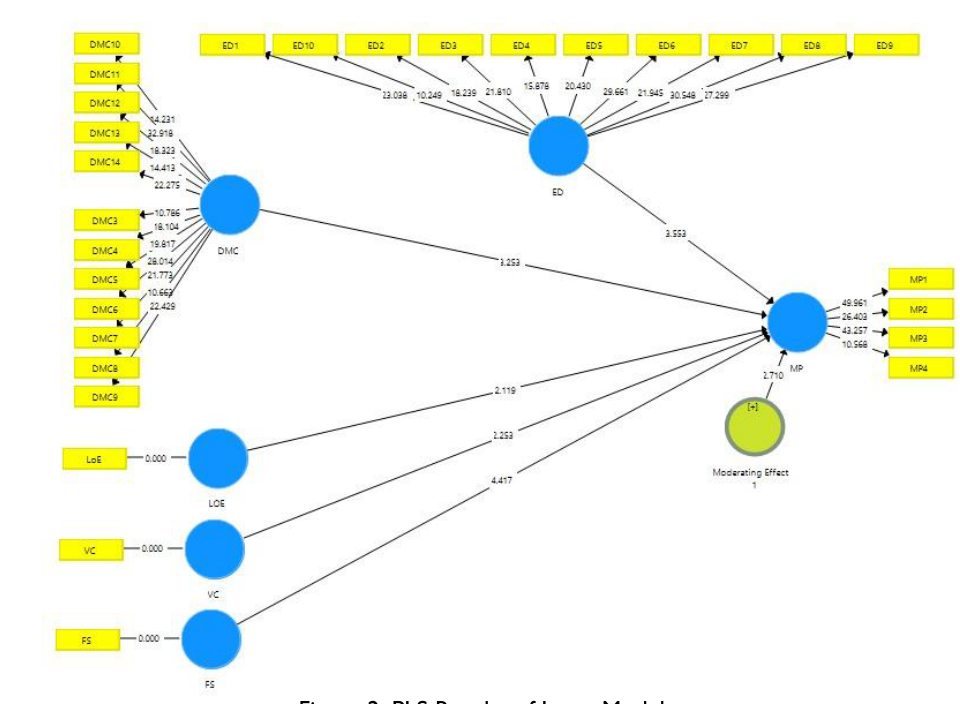
Figure 2. PLS Results of Inner Model